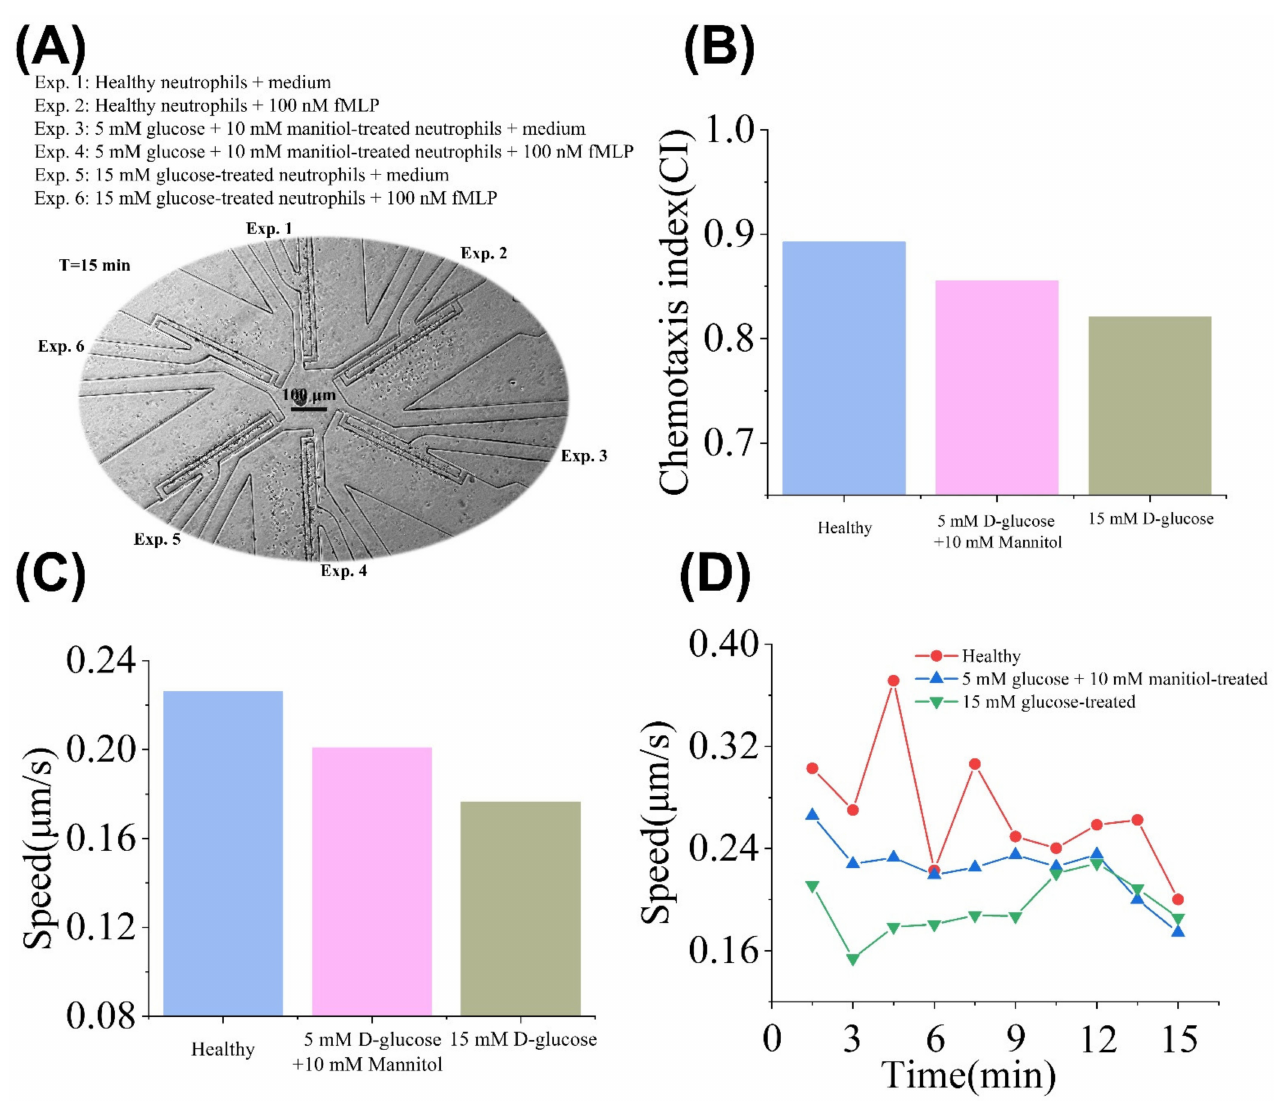
Figure 7. Chemotaxis of the healthy neutrophils, 15 mM D-glucose, and 5 mM D-glucose + 10 mM mannitol pretreated neutrophils. ( A ) Experiment setup and images in the SC 2 chip after 15 min. ( B ) Average CI values of the healthy neutrophils, D-glucose (5 mM) + mannitol (10 mM), and D- glucose (15 mM) pretreated neutrophils. ( C ) Average V values of the healthy neutrophils, D-glucose (5 mM) + mannitol (10 mM), and D-glucose (15 mM) pretreated neutrophils. ( D ) Time-dependent V values of the healthy neutrophils, 15 mM D-glucose, and 5 mM D-glucose + 10 mM mannitol pretreated